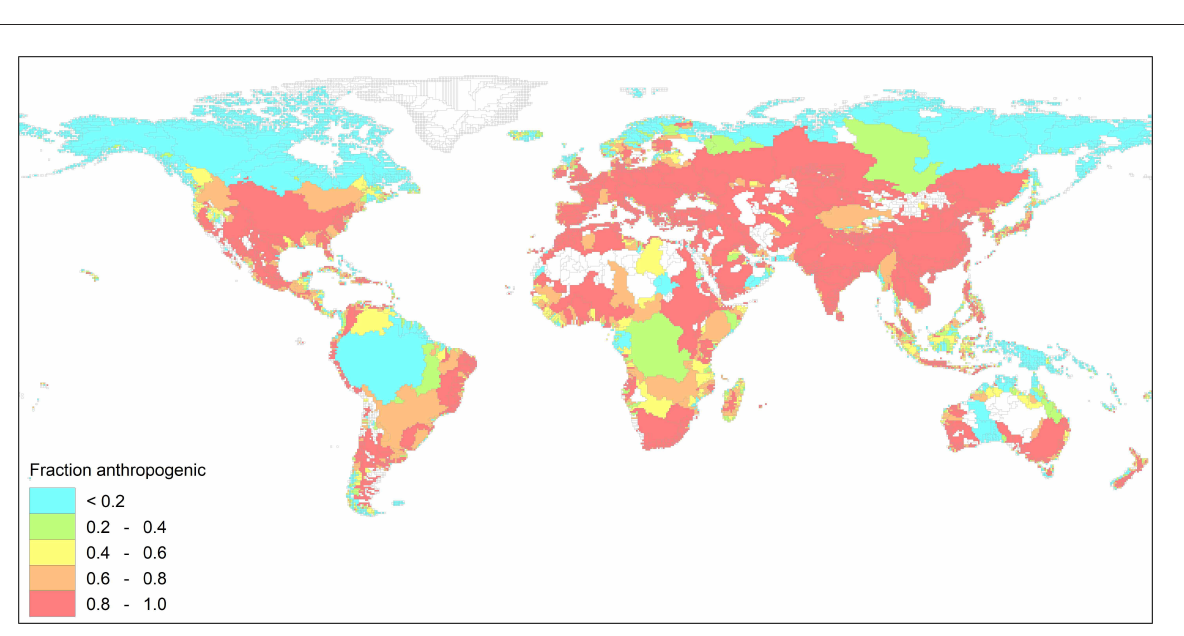
FIGURE4 Fraction anthropogenic sources in the river export to global coastal waters for the year 2015. The fraction anthropogenic is calculated as the maximum of the anthropogenic N or P sources.